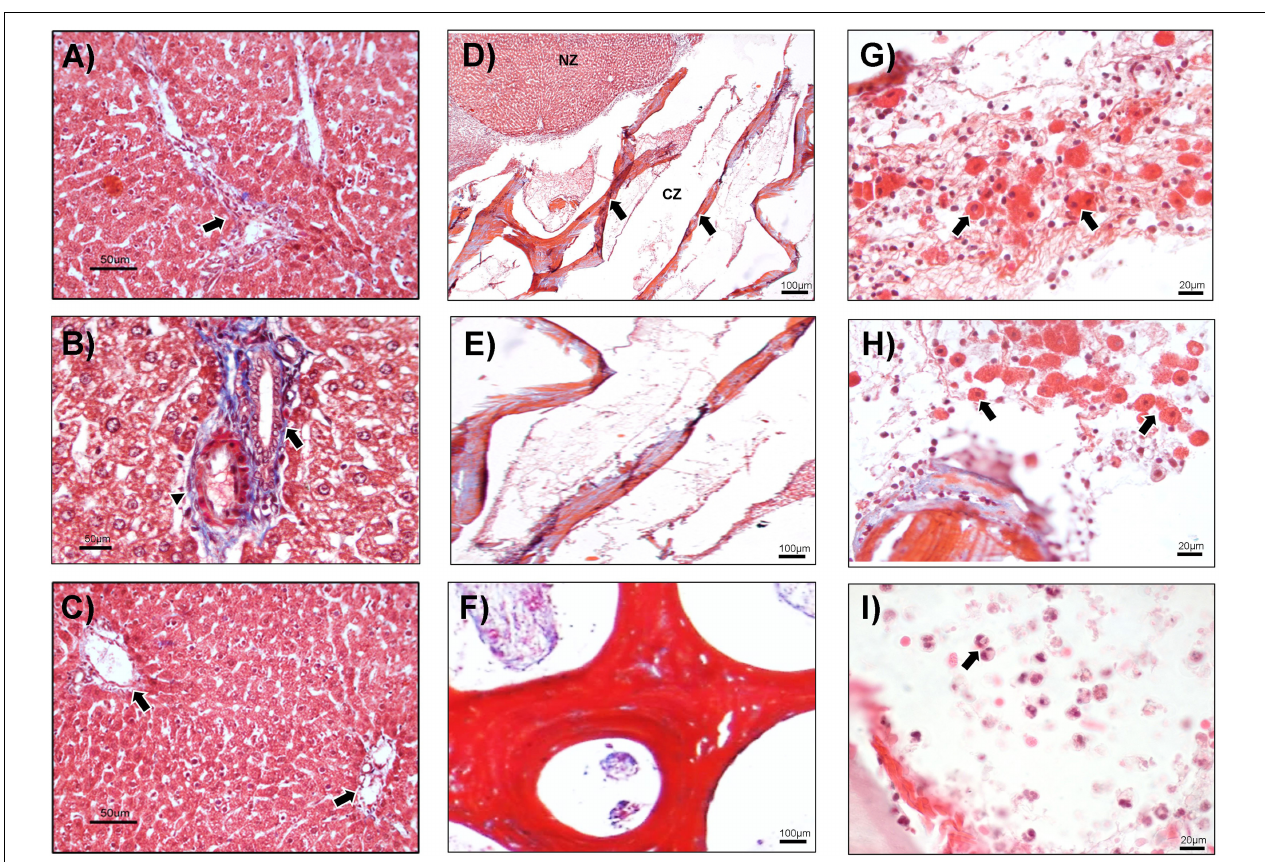
FIGURE 3 | Histological analysis at day 3. (A) The liver without hepatectomy (sham) with triad portal (arrow), 100 × . (B) In the PH group, the biliary duct (arrow) and hepatic artery (arrowhead) are shown, 400 × . (C) Basal tissue from the animals at implantation day 3, in which the typical arrangement of liver parenchyma and portal triads are observed (arrows), 100 × . (D–I) PH + CMS animals. (D) Normal zone (NZ) and CMS zone (CZ), liver tissue with CMS (arrows), 40 × . (E) CMS zone ( RZ) at high magnification, 100 × . (F) Trabeculae and pore of CMS, 400 × . (G,H) Hepatocyte-like cells (arrows) around the CMS, 100 × . (I) Inflammatory cells (arrows) in the CMS, 100 × . Representative images with Masson’s trichrome